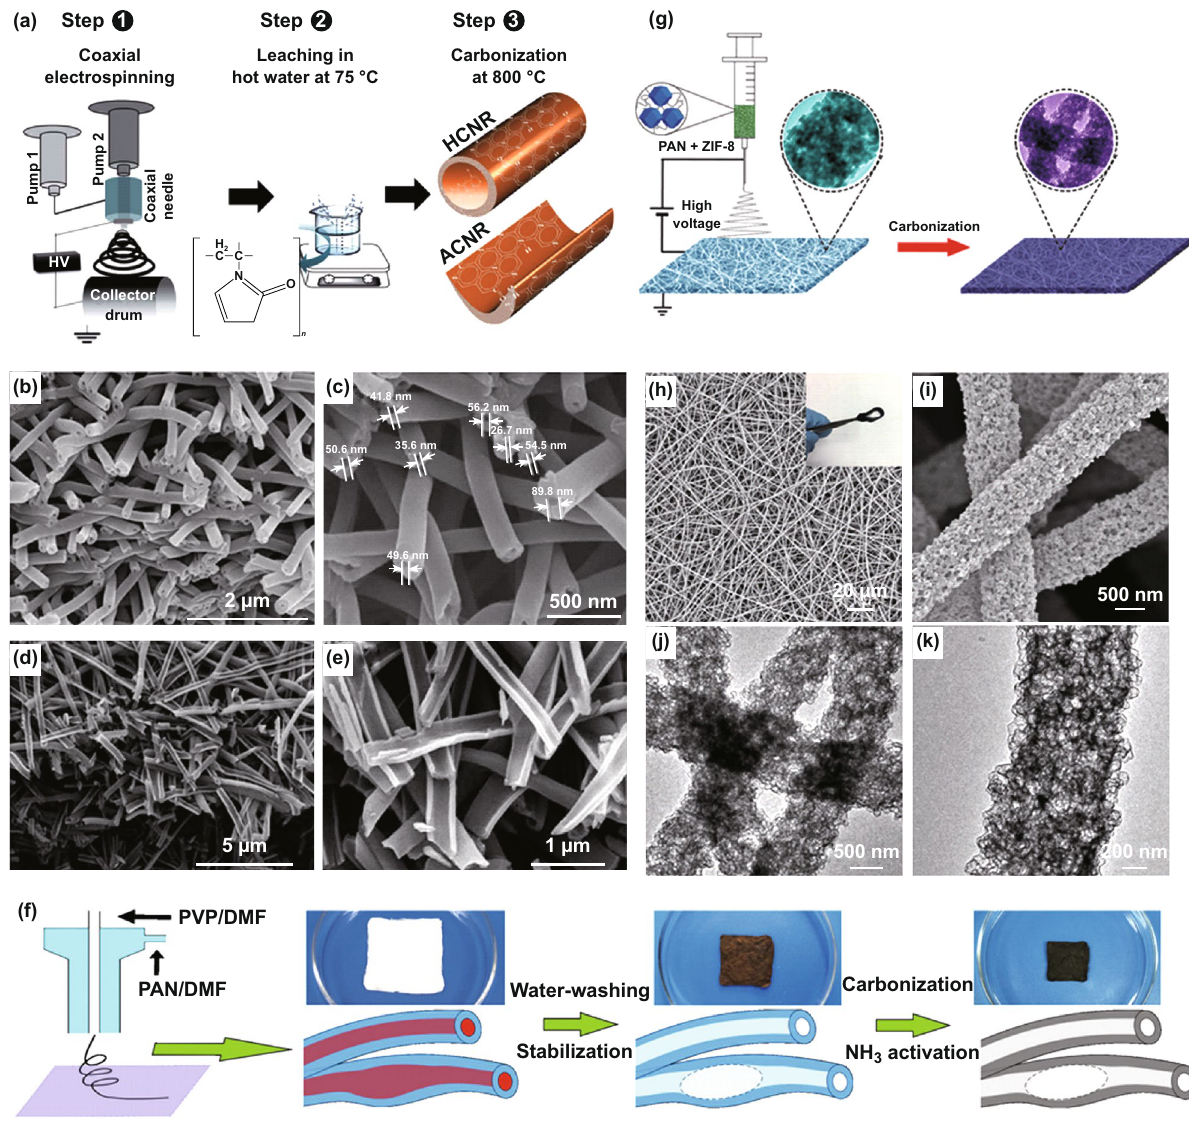
Fig. 7 a Schematic illustration of the synthesis of HCNR and ACNR samples by co-axial electrospinning. SEM images of b , c HCNR, and d , e ACNR, respectively. Reproduced with permission from Ref. [108]. Copyright 2015, Royal Society of Chemistry. f Schematic illustration of the fabricating process of HCNF. Reproduced with permission from Ref. [109]. Copyright 2015, Elsevier. g Schematic illustration of the synthesis of HPCNFs-N. h , i SEM, and j , k TEM images of the HPCNFs-N. Reproduced with permission from Ref. [117]. Copyright 2017, Royal Society of